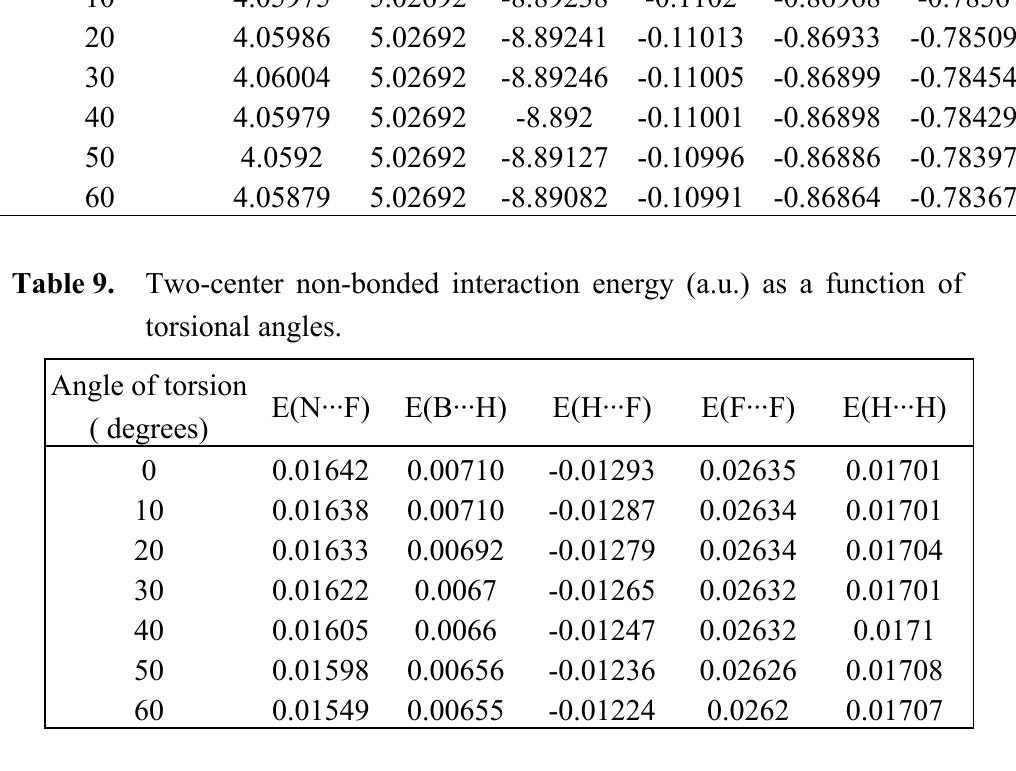
Table 10. One-center energy (a.u) as a function of torsional